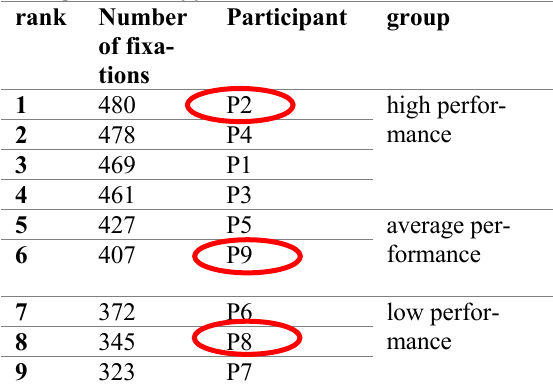
Figure 21. Network visualization of EM data for partic- ipant P2, during Climbing.